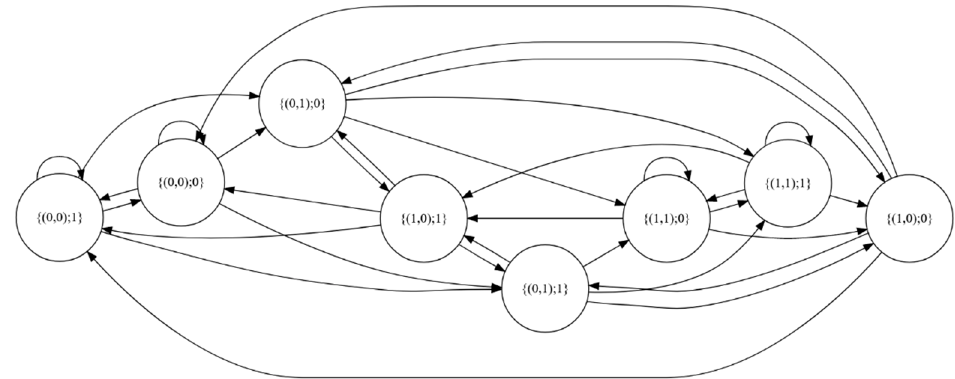
Figure 2. Graph of the change process in SMBTR(25,2,1,300) model. Source: author.